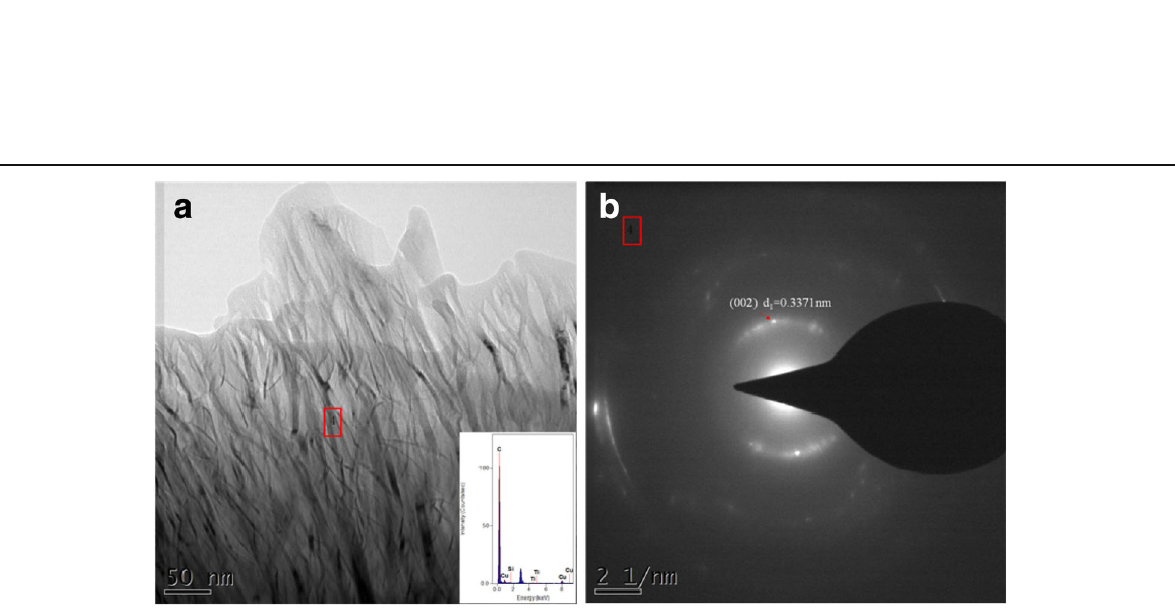
Fig. 7 a TEM image of graphenes in sintered nanocomposites with 0.5 wt% graphenes and 0.5 wt% MWCNTs. b Diffraction patterns from Fig. 7a. Inserted in Fig. 7a is a EDS spectra taken from Fig.